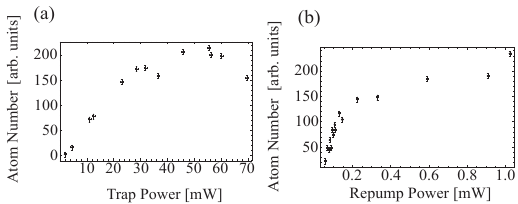
Figure 22. ( a ) Steady state atom number as a function of trap laser power. The atom number is inferred by recording the trap fluorescence on a photodiode. The voltage recorded by the detector can be converted into atom number. The maximum voltage corresponds to an atom number of ∼ 10 7 . Since the trap laser is retro-reflected through the vacuum chamber, the laser power incident on the atoms is approximately twice the trap laser power. ( b ) Atom number as a function of repump laser power. For both of these experiments, the trap laser detuning was fixed at 15 MHz below resonance, the trapping beam diameter was ∼ 0.90 cm and the magnetic field gradient was ∼ 7